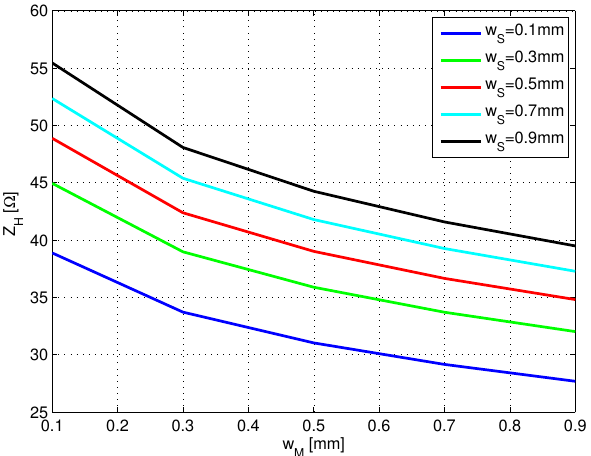
Figure 3: Required characteristic impedance of the host transmission line at 4 GHz as a function of the slot and stub widths, according to (2b).